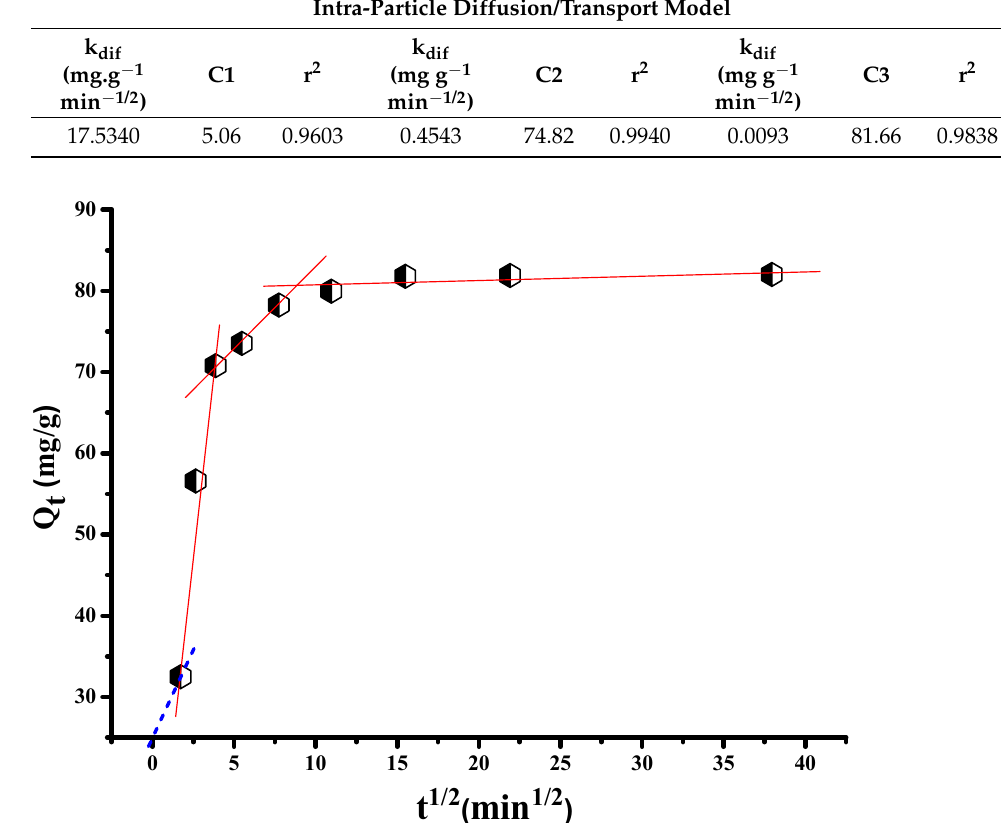
Table 2. Adsorption rate control mechanism parameters for removing RhB by MgTiO 3 @g-C 3 N 4 nanohybrid. Intra-Particle Diffusion/Transport Model